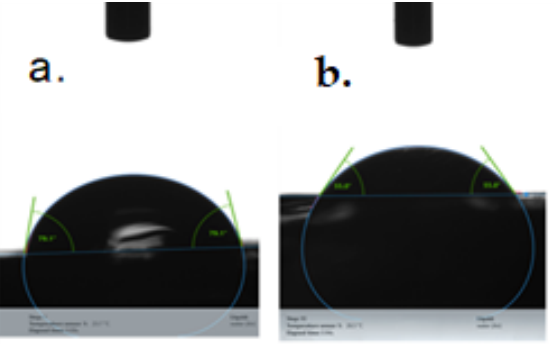
Figure 10. Water contact angle on the samples based on: ( a ) GelMA20% + 0.5% I-2959 and ( b ) GelMA 20% + 1% I-2959.